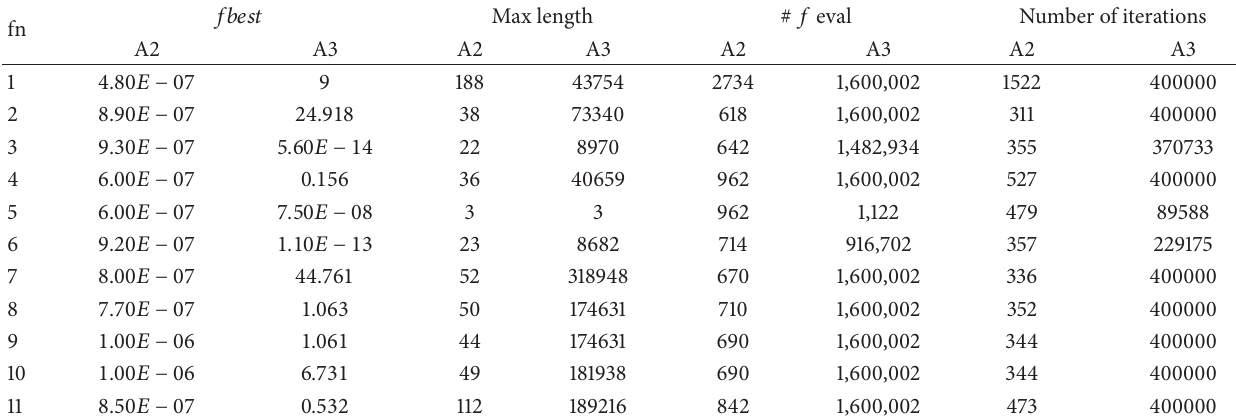
Table 1: The value of the best found, the maximum list length, the number of function evaluations, and the number of iterations from Ichida- Fujii A2 and Hansen A3 when 𝑛 = 10 .